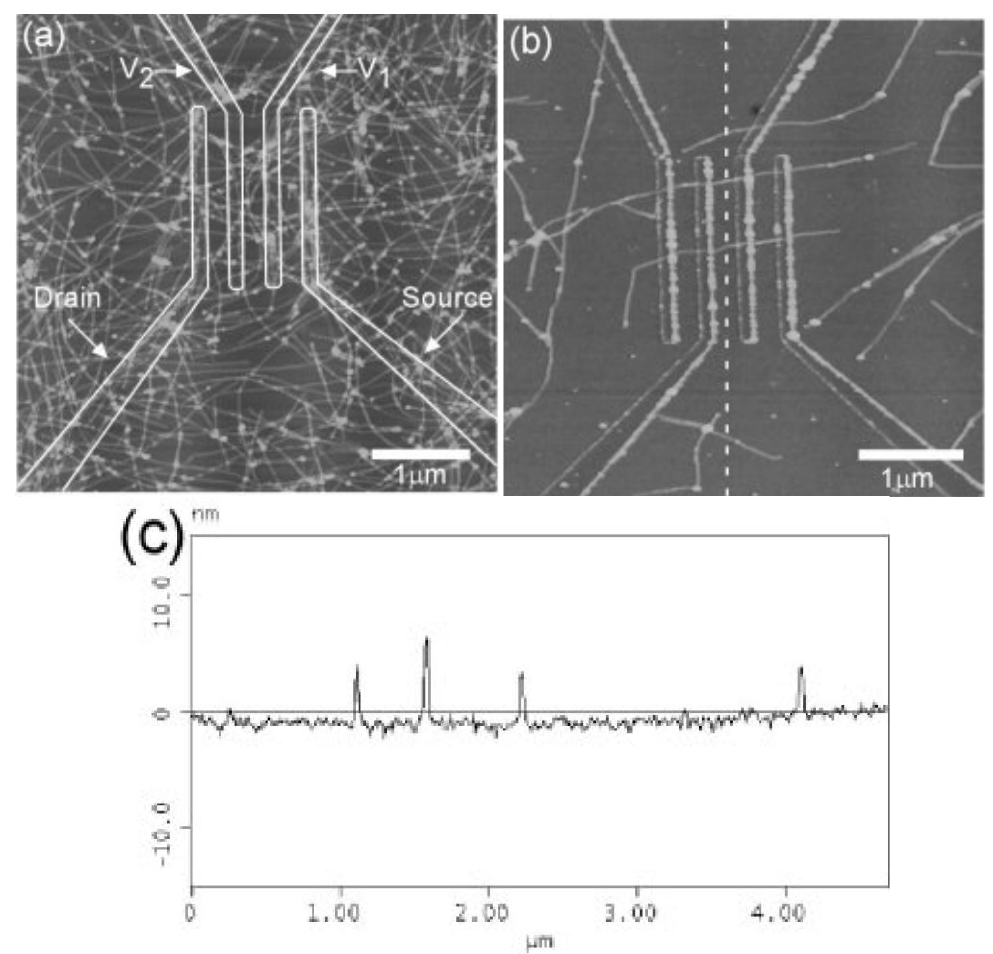
Figure 4. ( a,b ) AFM image of P3HT nanofibers across electrodes on SiO ( c ) cross section of the dashed line shown in (b). The fibre heights from top to bottom are 5.6, 6.3, 3.9, and 3.3 nm. (Reprinted with permission from Reference [67]. Copyright (2003) by the Wiley-VCH Verlag GmbH &